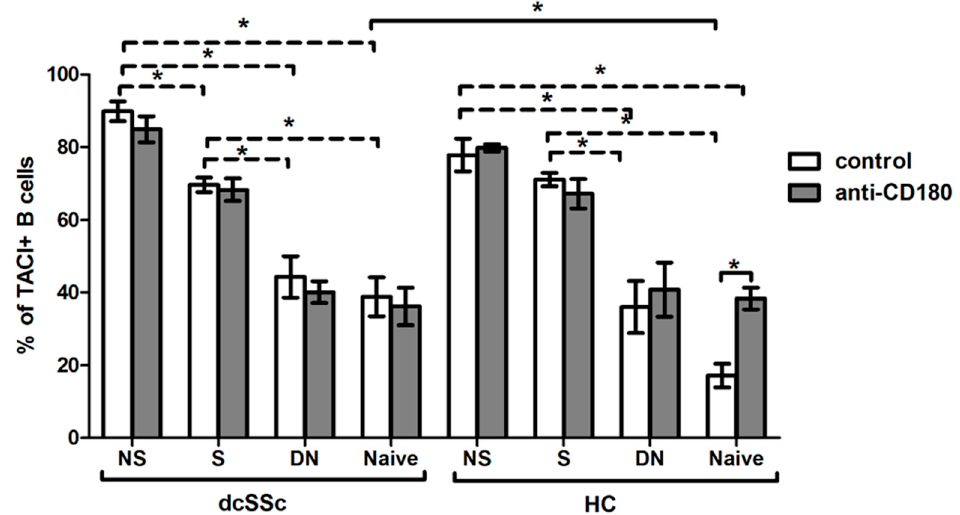
Figure 5. Changes in the TACI expression of B cell subsets in dcSSc ( n = 4) and HCs ( n = 4) after CD180 stimulation. The ratio of TACI-positive B cells in CD27+IgD+ non-switched memory (NS), CD27+IgD- switched memory (S), CD27-IgD- double negative (DN) and CD27-IgD+ naive B cell subsets with anti-CD180 antibody stimulation or left unstimulated. The solid lines show significant differences between dcSSc patients and HCs, and between unstimulated and stimulated conditions, while the dashed lines indicate significant differences between unstimulated B cell subsets within groups. Data are presented as means ± SEM. * p < 0.05.